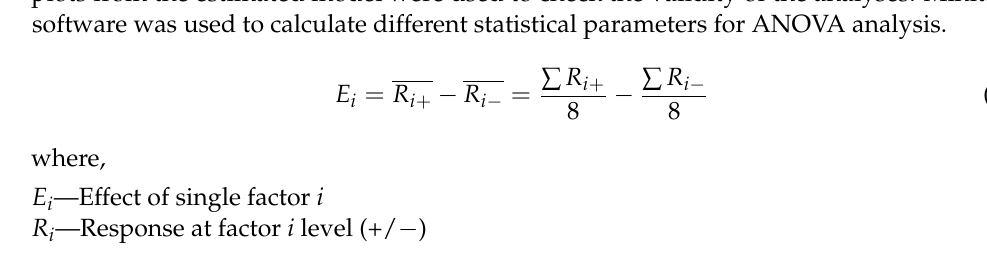
Table 6. Experimental conditions for a fractional factorial design.